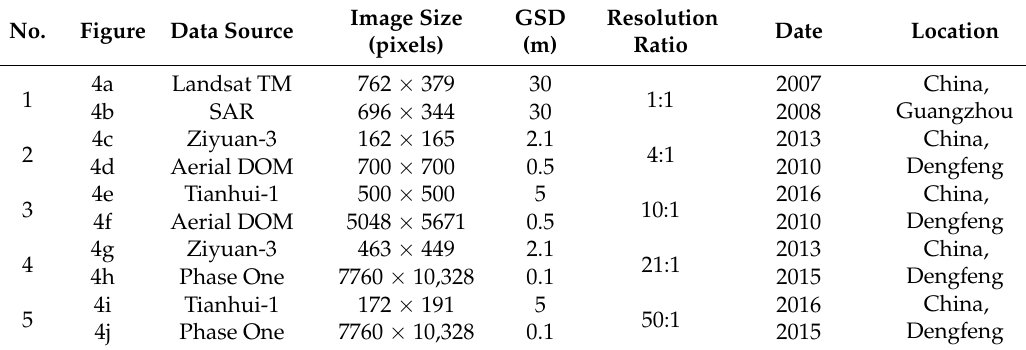
Table 1. Specific parameters of image pairs to be registered. GSD: ground sampling distance; SAR: synthetic aperture